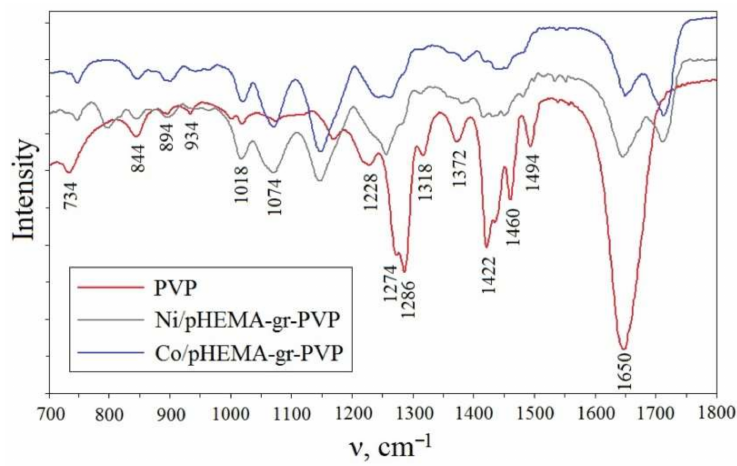
Figure 2. ATR FTIR spectra of PVP and FMF/pHEMA-gr-PVP composites (HEMA:PVP = 80:20 mass parts, FMF content—[FMF] = 10